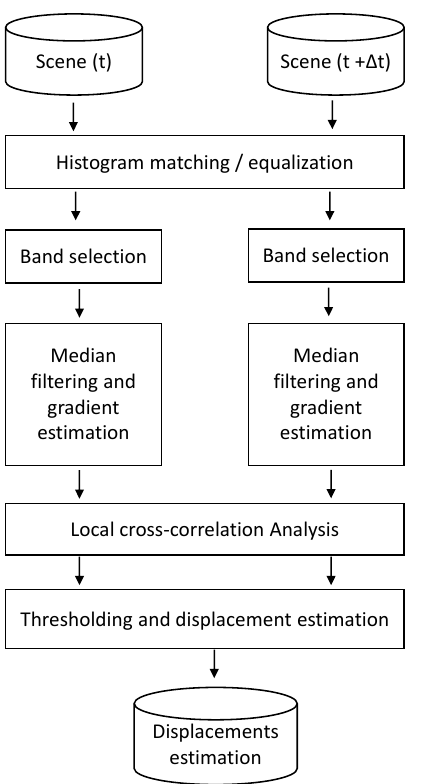
Figure 15. Procedure of feature tracking from very high-resolution optical images.